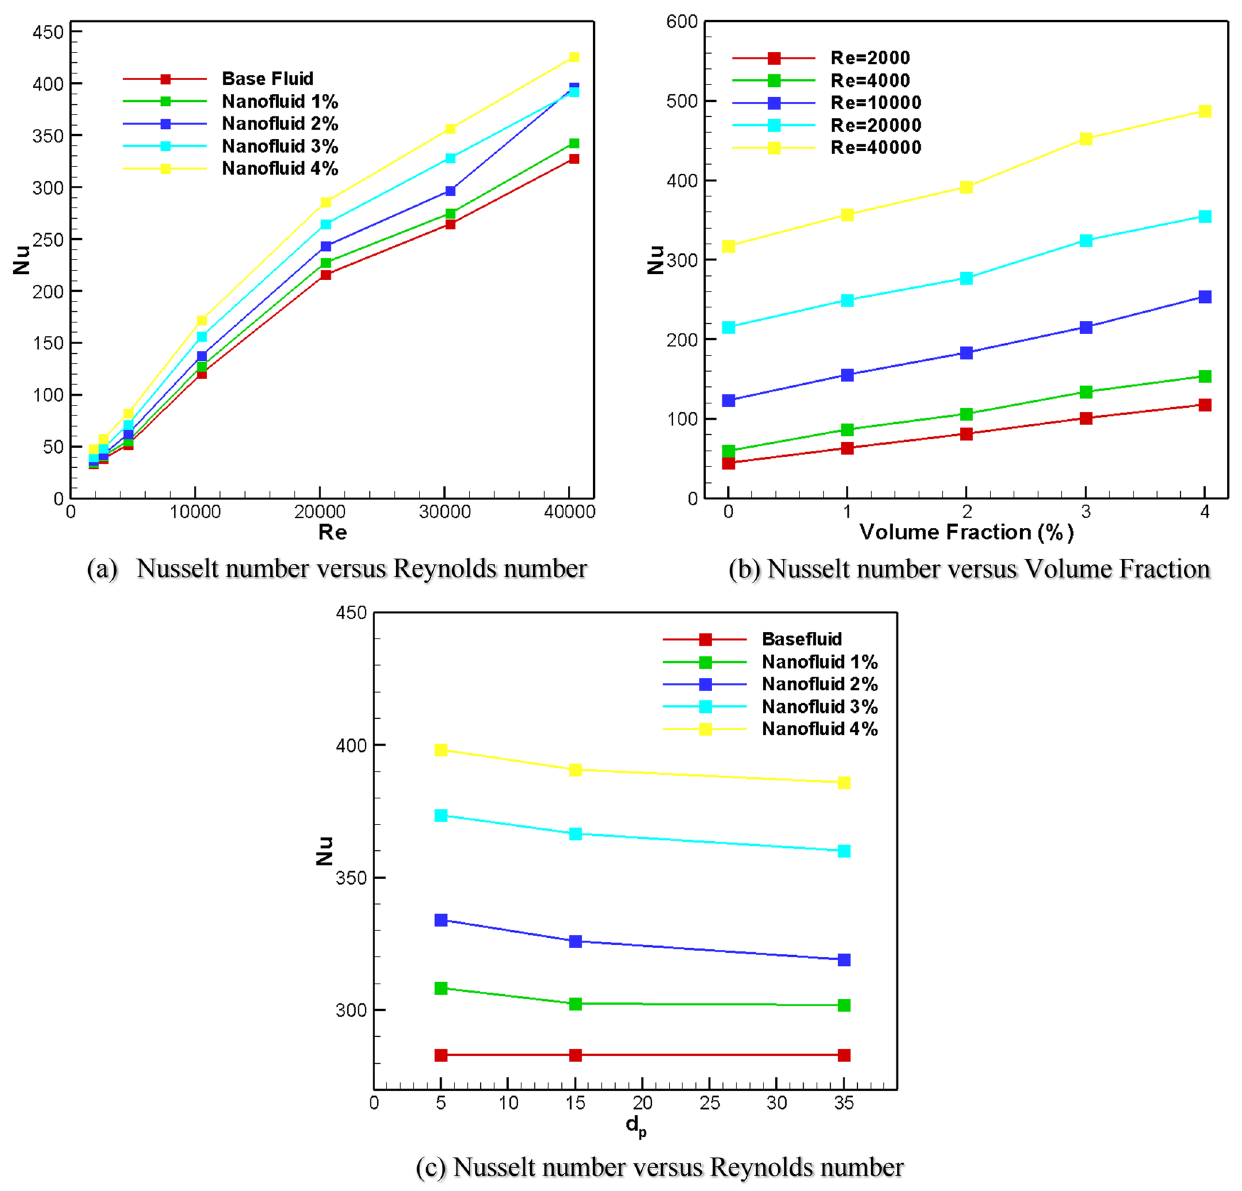
tion for comparison between the all adopted Reynolds. c The Nus- selt number versus nanoparticle diameter for comparison between the base fluid and different Friction factors